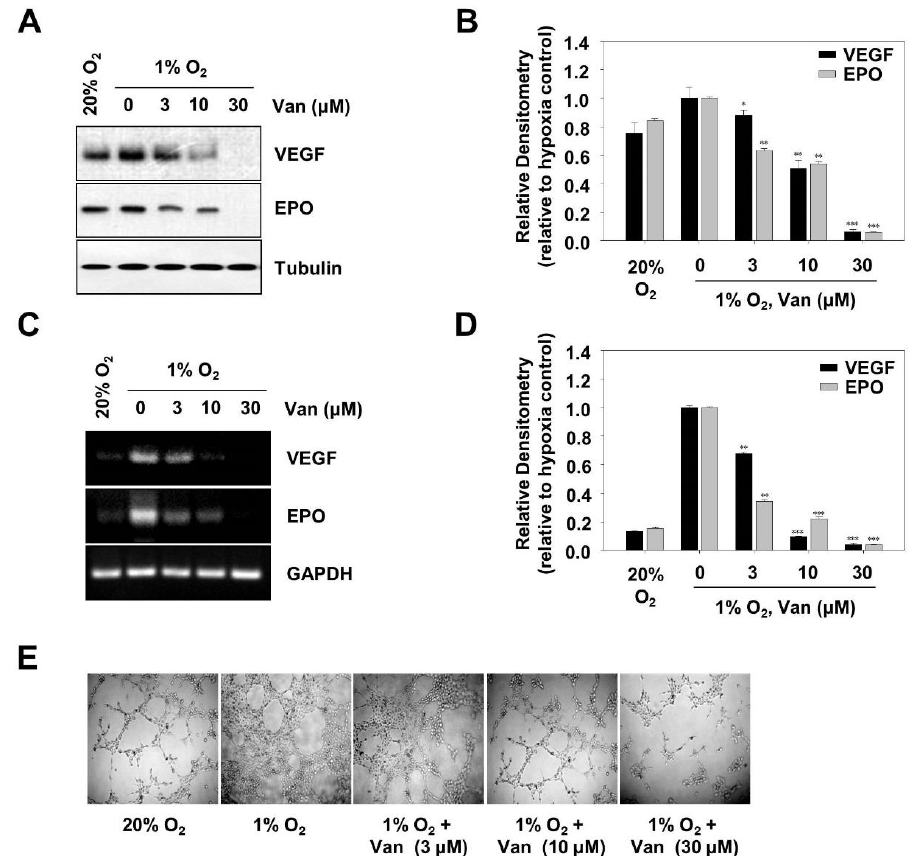
Figure 5. Vanillic acid (Van) inhibits tumor angiogenesis. ( A ) HCT116 cells were pretreated without